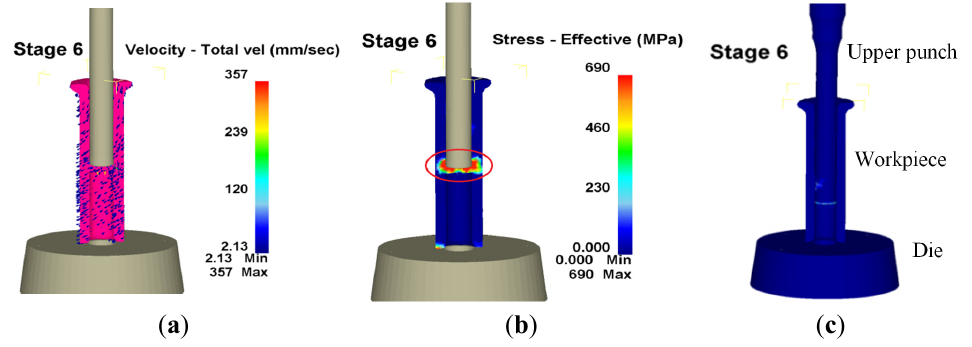
( c ) Figure 13. Velocity, effective stress and wear distribution of the fifth stage in 3D. ( a ) Velocity; ( b ) Effective stress; ( c ) Wear. Regarding the via-hole at the sixth stage, the workpiece bed stood up to the die. Furthermore, waste was punched out after the punch top came into contact with the workpiece in which the punch size at the sixth stage became the final aperture of the formed product. Figure 14 presents workpiece velocity, effective stress and wear distribution during the sixth stage, in which the largest wear appears in the red circle. In the via-hole process, friction on the upper punch resulted in it having the maximum wear, with